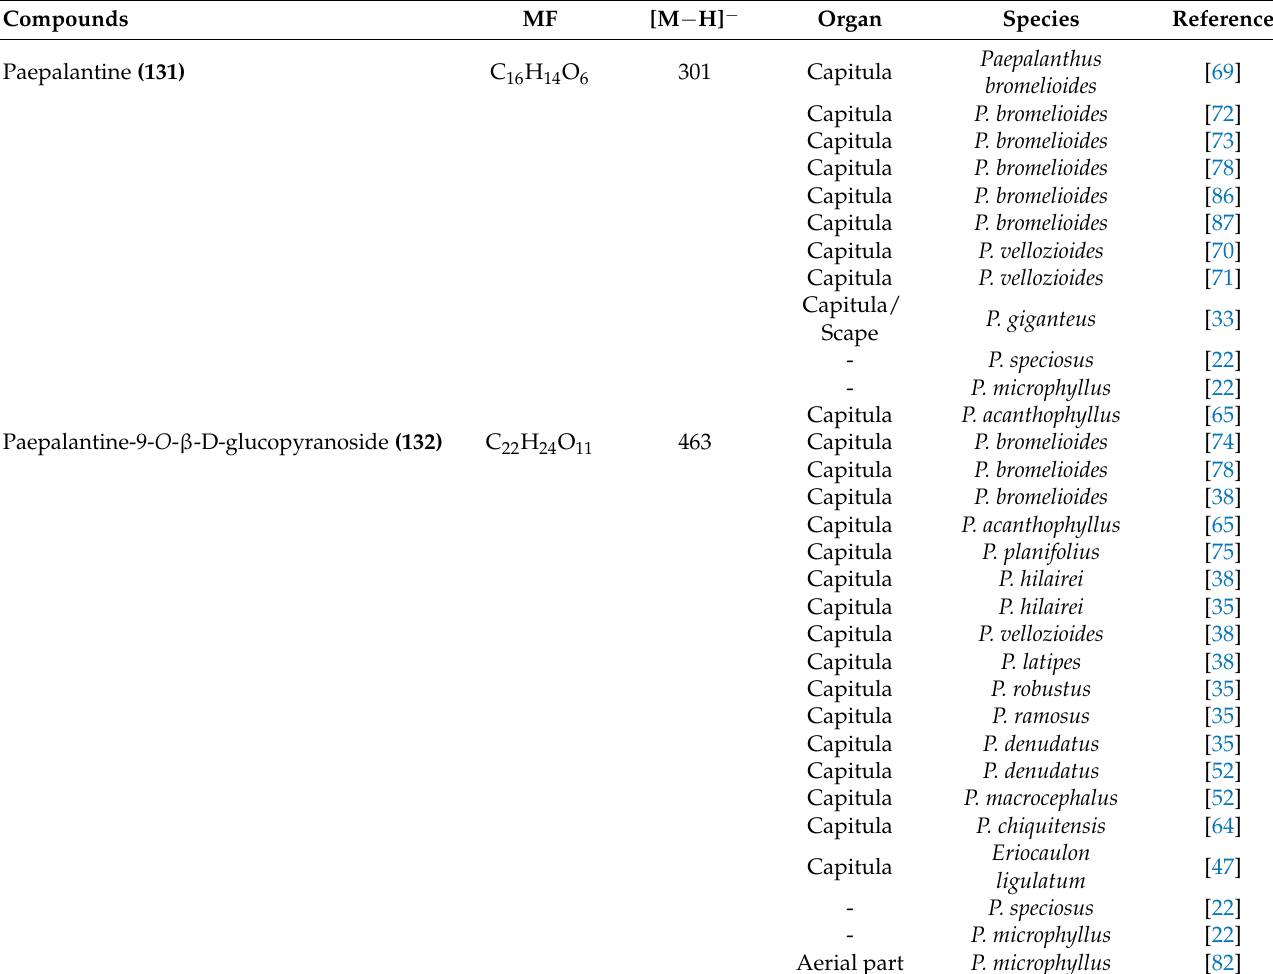
Table 2. Naphthopyranones isolated from Eriocaulaceae